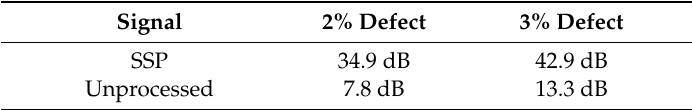
Figure 8. Zoom in around the defect area from 0.5% CSA up to 8% CSA. Table 2. Signal-to-noise ratio (SNR) enhancement of experimental signal.